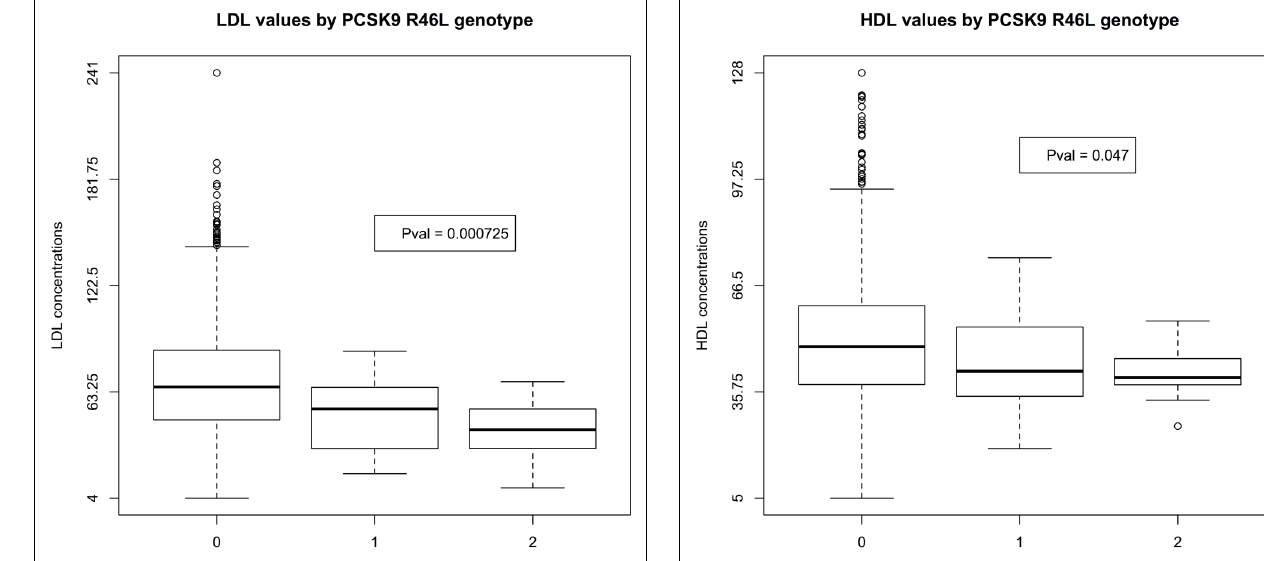
There was insufficient data to assess the statistical signifi- cance of C679X genotypes. Linear regression of EMR-derived age-corrected serum LDL concentrations against R46L genotypes was statistically significant ( P -value 7 × 10 − 4 ) and directions of effect consistent with the LOF allele reducing LDL